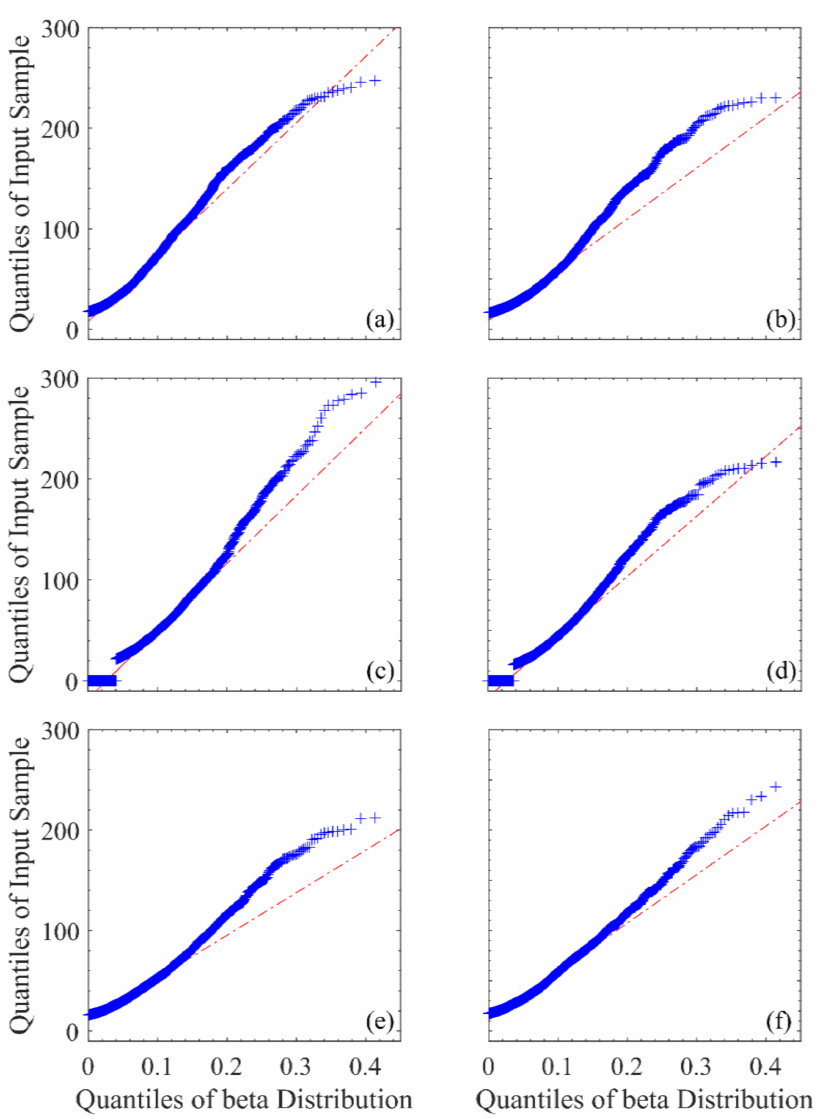
Figure A5. Q-Q plot for the resulting pore size distributions for each VISF test at 271 K considering a Beta distribution with α = 1.2 and β = 15. Tests on the left ( a , c , e ) are ON-shelf, while tests on the right ( b , d , f ) are OFF-shelf. ( a , b ) are for sucrose 5%, c and d are for mannitol 5% and e and f are for dextran